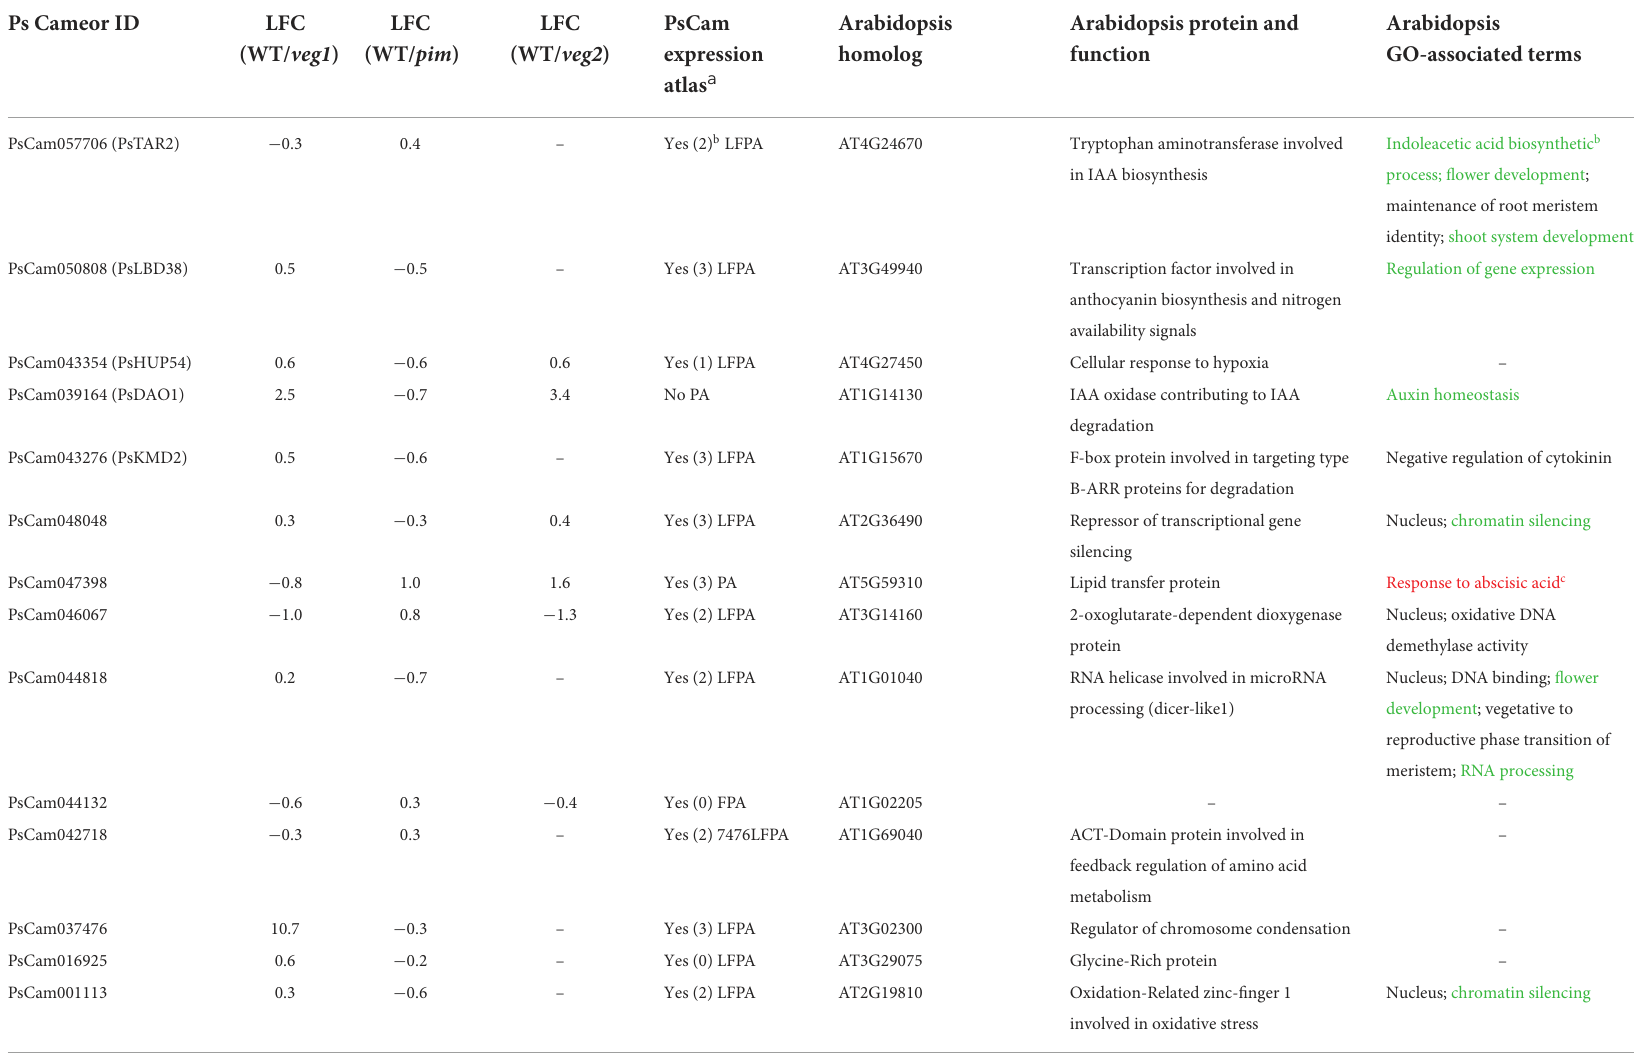
TABLE 1 Genes selected for RT-qPCR and further expression